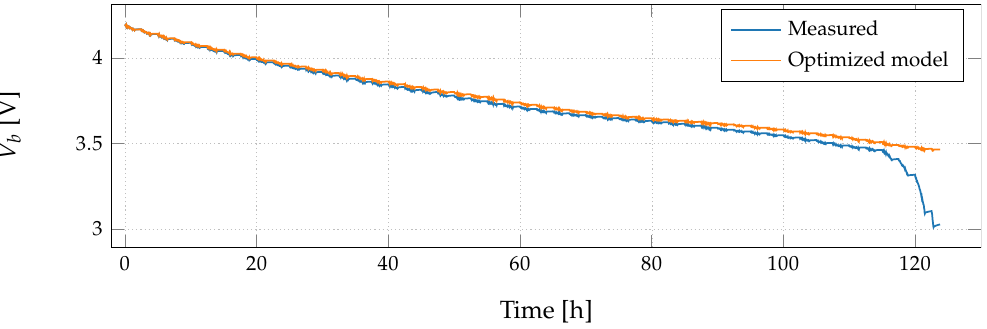
Figure 18. Performance of the model with an optimized ζ a for the first experiment on the whole random load test.